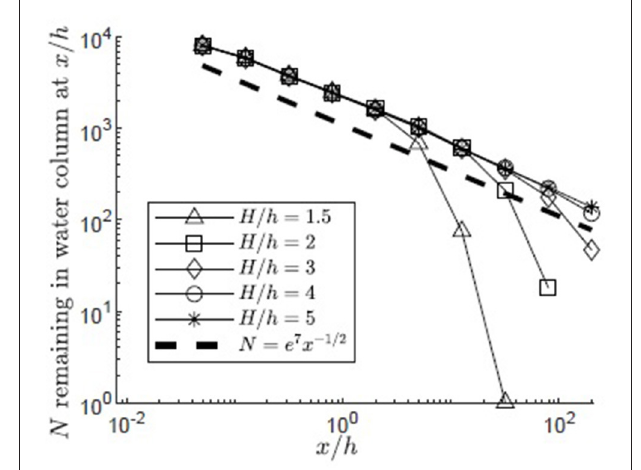
FIGURE 5 | Modeled (solid, dashed, and dash-dot lines) and measured (open FIGURE 6 | Number of particles remaining in the water column with distance circles, triangles, and squares) velocity profiles within a Z. marina canopy from the release point x rel / h 0 for 10,000 filamentous particles released at (Shaw Island, WA; Lacy and Wyllie-Echeverria, 2011) at three points during a = z rel / h 1 in a canopy ( u 0.01 m/s, L v 1 cm, a 2 m − 1 , C D 1.95, tidal cycle, with canopy height h 0.84, 0.78, 0.61 m, denoted by solid black = = = = = ∗ = h 1 m) with varied submergence depth, H / h 1.5, 2, 3, 4, 5, respectively, dot, and 1 U 0.032, 0.050, 0.072 m / s , L v 1 cm, C D 1.95, and a 2 = = = = = = represented by open triangles, squares, diamonds, circles, and asterisks. m − 1 . Particles were evaluated at 10 points spaced equally in log space, ( x / h = 0.05, 0.13, 0.32, 0.80, 2.0, 5.0, 13, 32, 80, 200). Particles reaching the water H / h ) were reflected off of the surface boundary, remaining surface ( z / h = available for transport within the water column and the possibility of capture on canopy elements. A line illustrating a power law with decay constant 1/2 is − plotted for reference (black dashed line).